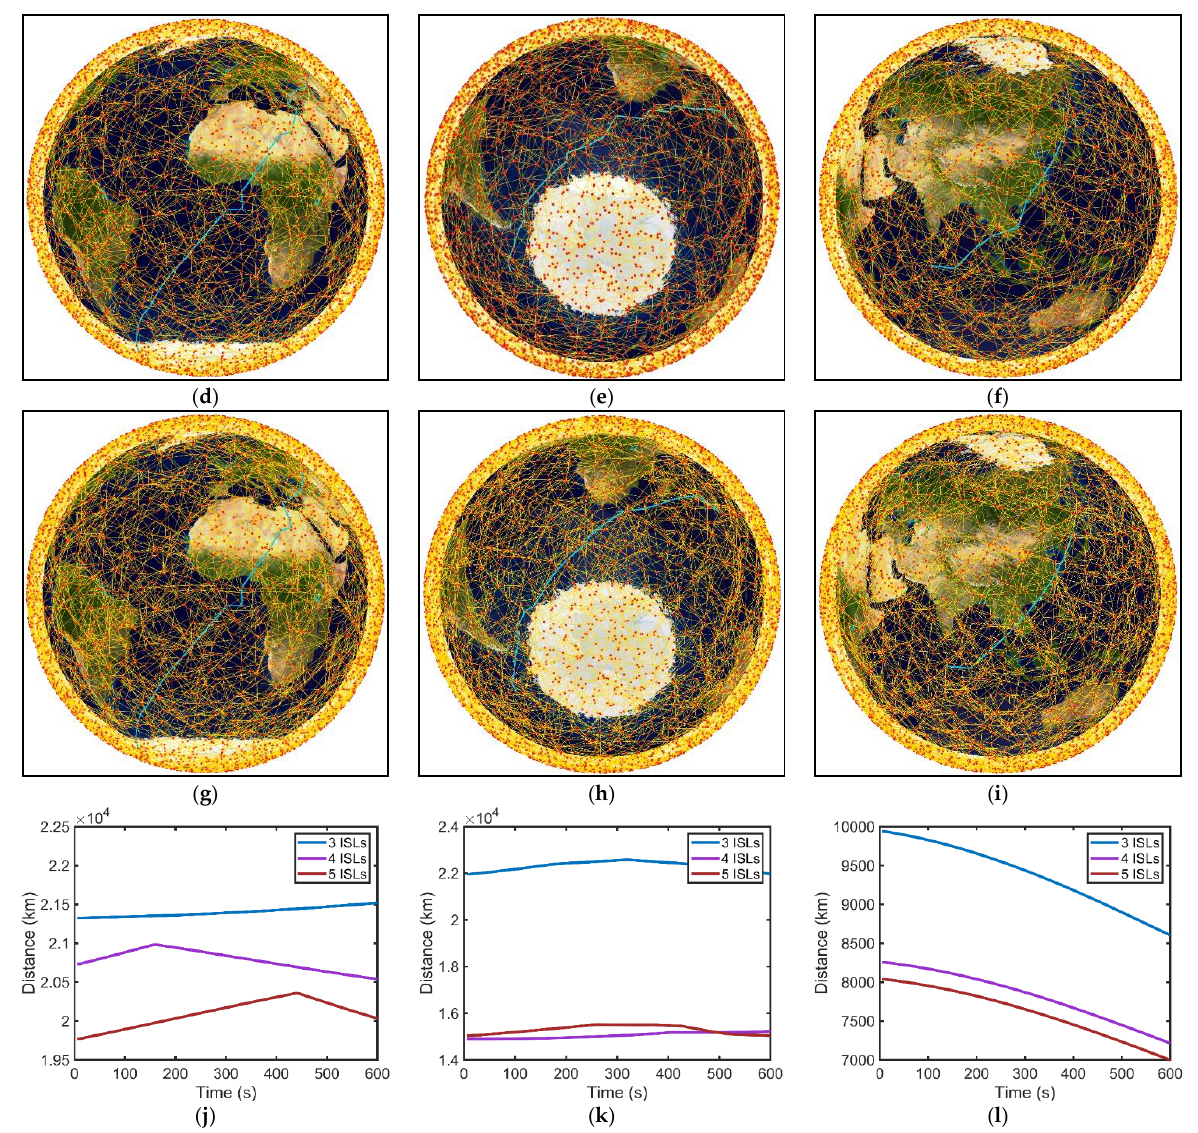
Figure 10. Comparison of data transmission paths on any 3 groups of satellite nodes in the mixed Walker constellation proposed in the paper with 3, 4, and 5 ISLs on the satellite, respectively. ( a ) 3 ISLs per satellite; ( b ) 3 ISLs per satellite; ( c ) 3 ISLs per satellite; ( d ) 4 ISLs per satellite; ( e ) 4 ISLs per satellite; ( f ) 4 ISLs per satellite; ( g ) 5 ISLs per satellite; ( h ) 5 ISLs per satellite; ( i ) 5 ISLs per satellite; ( j ) Comparison of 3 ISL schemes for continuous communication; ( k ) Comparison of 3 ISL schemes for continuous communication; ( l ) Comparison of 3 ISL schemes for continuous communication.